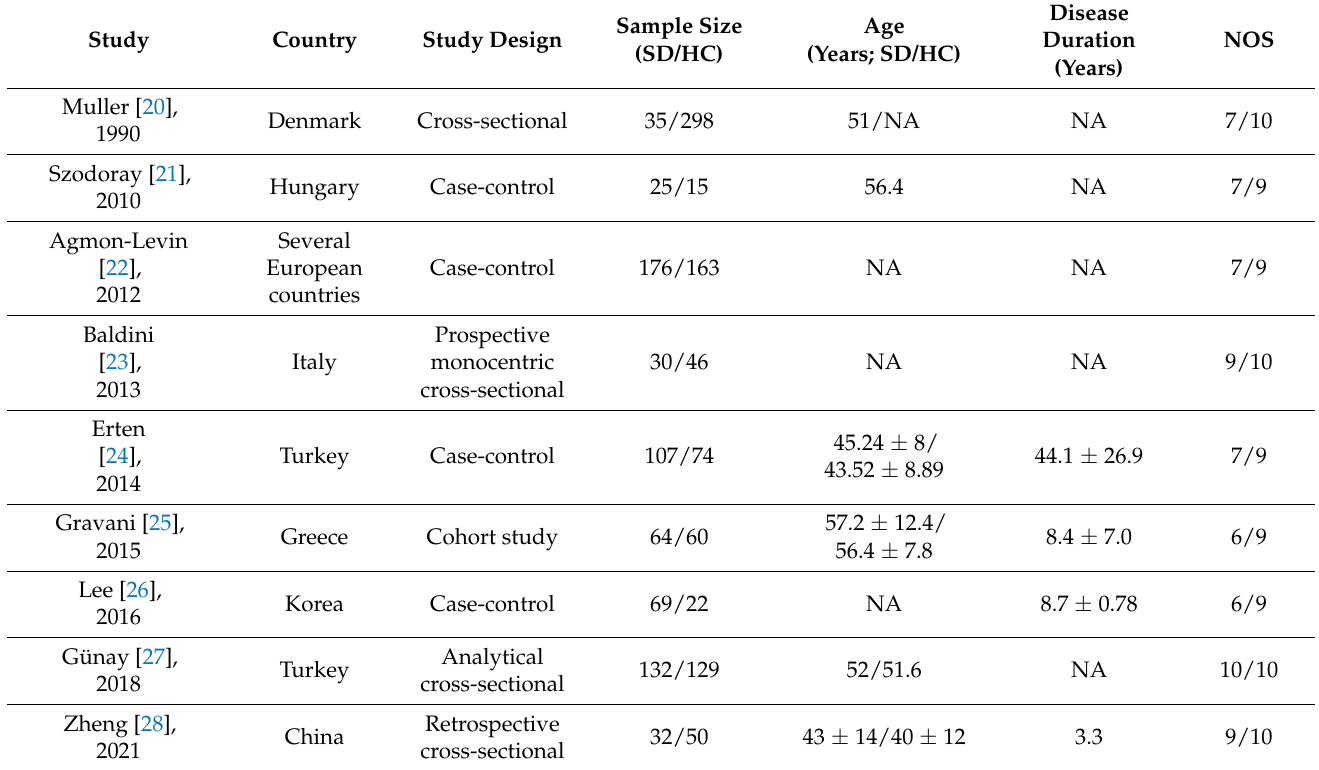
Table 1. Summary of the selected clinical studies.